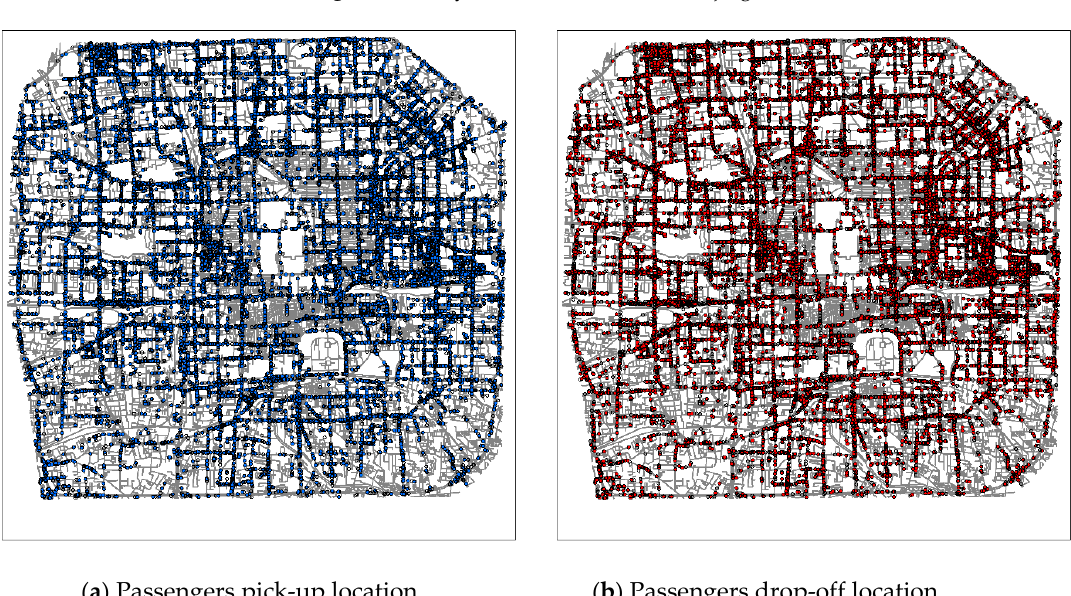
Figure 4. Study area: the core area of Beijing.